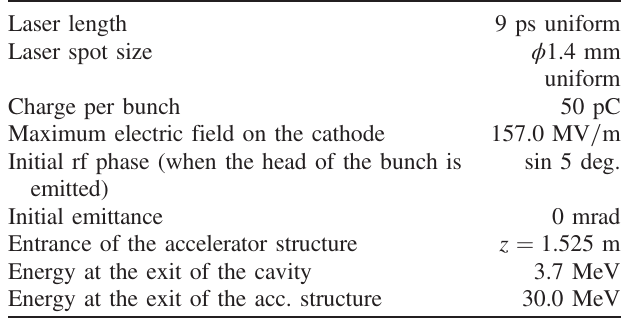
TABLE III. Parameters for low-emittance beam dynamics calculations in the SPring-8 rf gun injector system.